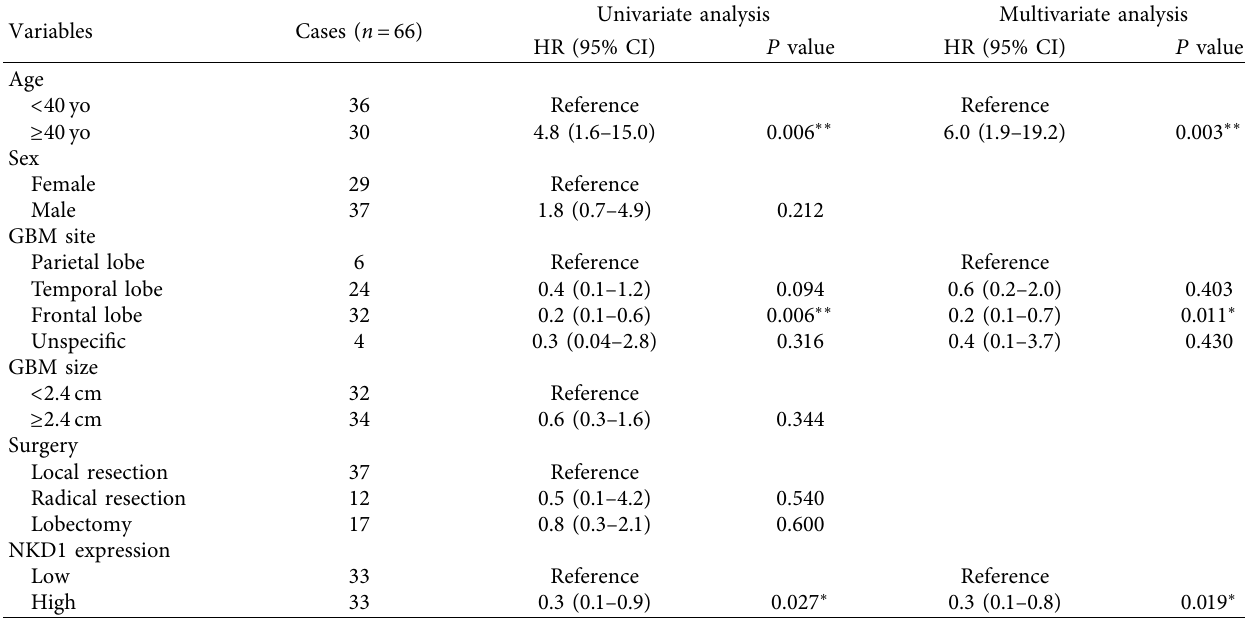
Figure 3: Survival analyses of GBM patients in our medical center. Cancer-specifc survival analyses were conducted according to patients’ Table 1: Cancer-specifc survival